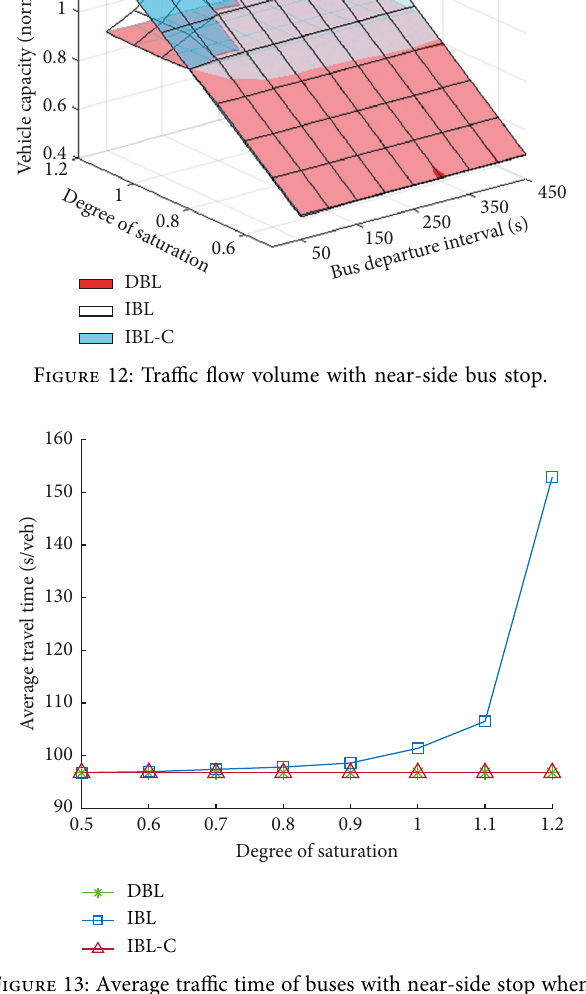
Figure 13: Average traffic time of buses with near-side stop when the interval of buses is random.